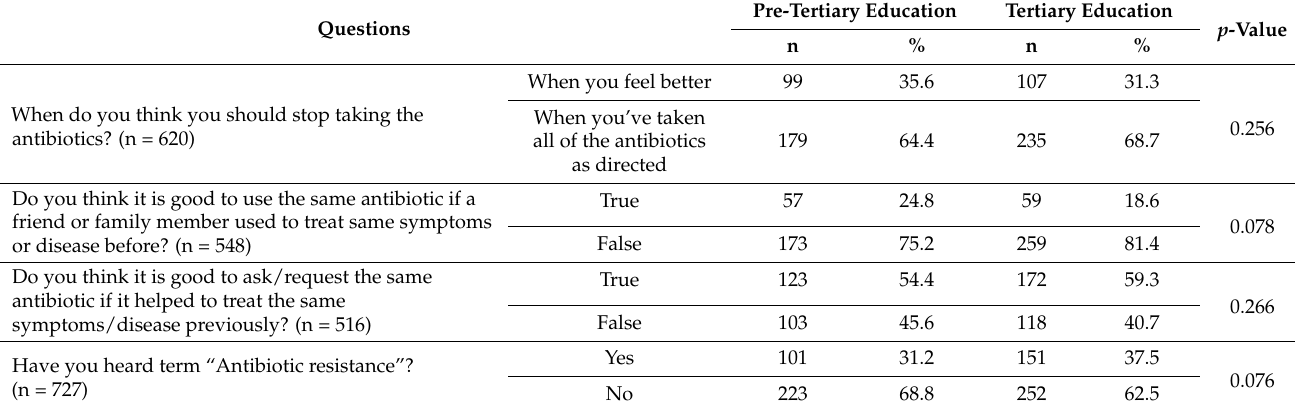
Table 4. Awareness about antibiotic use and resistance by education